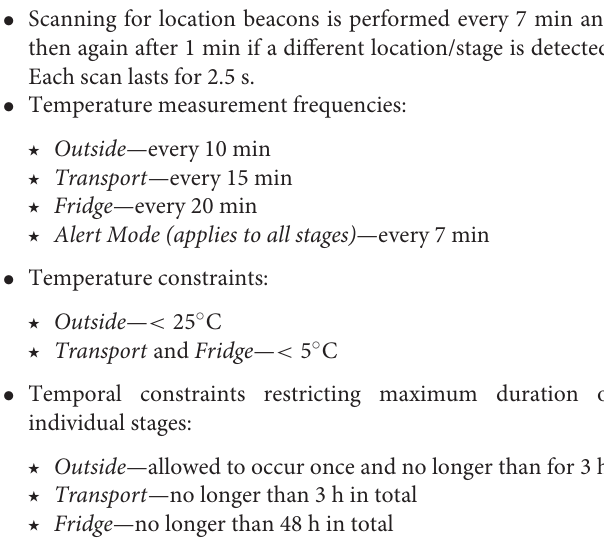
provide a summary of lessons learnt relating to the accuracy and quality of the IoT devices